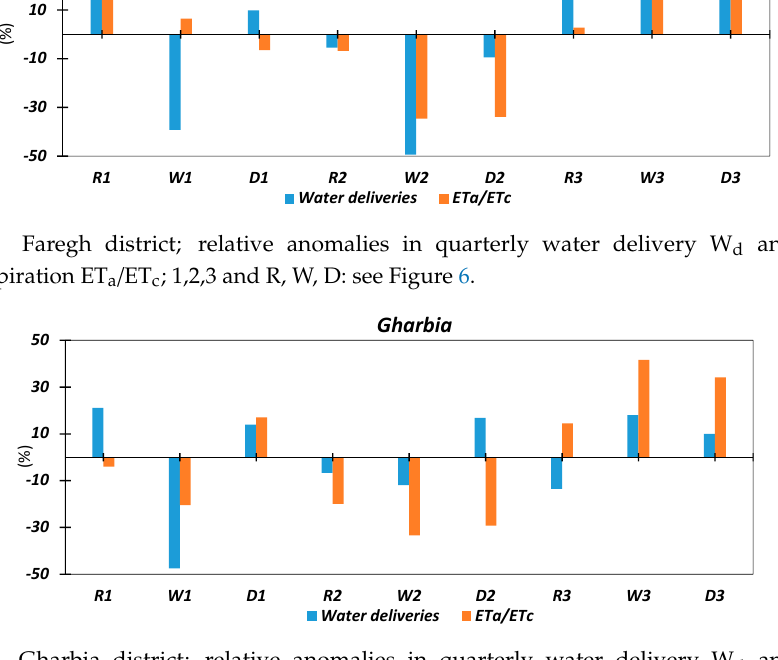
Figure 12. Faregh district; relative anomalies in quarterly water delivery W d and relative evapotranspiration ET a /ET c ; 1,2,3 and R, W, D: see Figure 6.